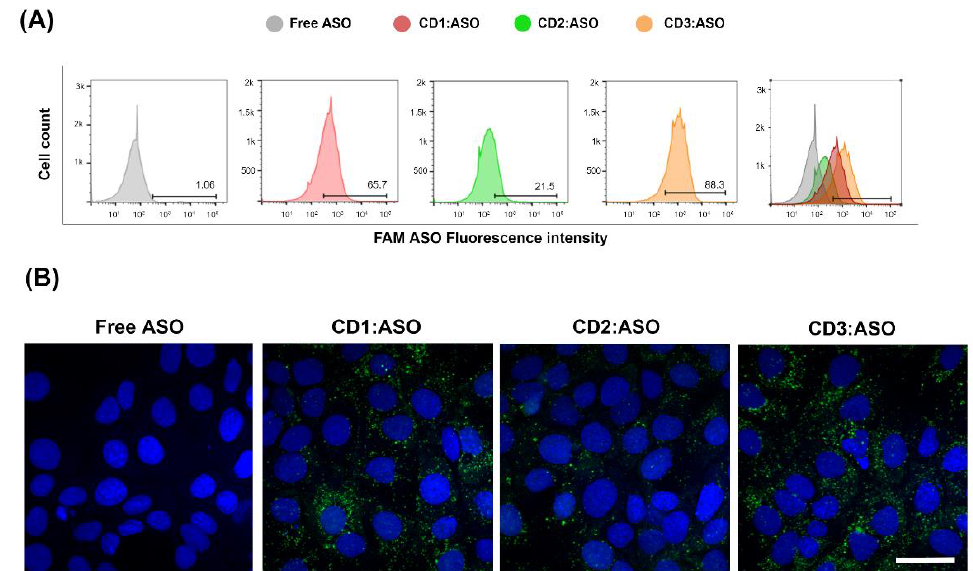
Figure 3. Cellular uptake of cyclodextrins (CDs):ASO nanocomplexes. ST14A (1.5 × 10 5 ) cells were treated with ASO alone or complexed with CDs (100 nM final concentration) for 6 h. ( A ) Representative flow cytometry histogram of CDs:ASO nanocomplexes internalization. ( B ) Intracellular fluorescence of FAM-labelled ASO (green) and nuclei (blue). Scale bar: 25 μm .